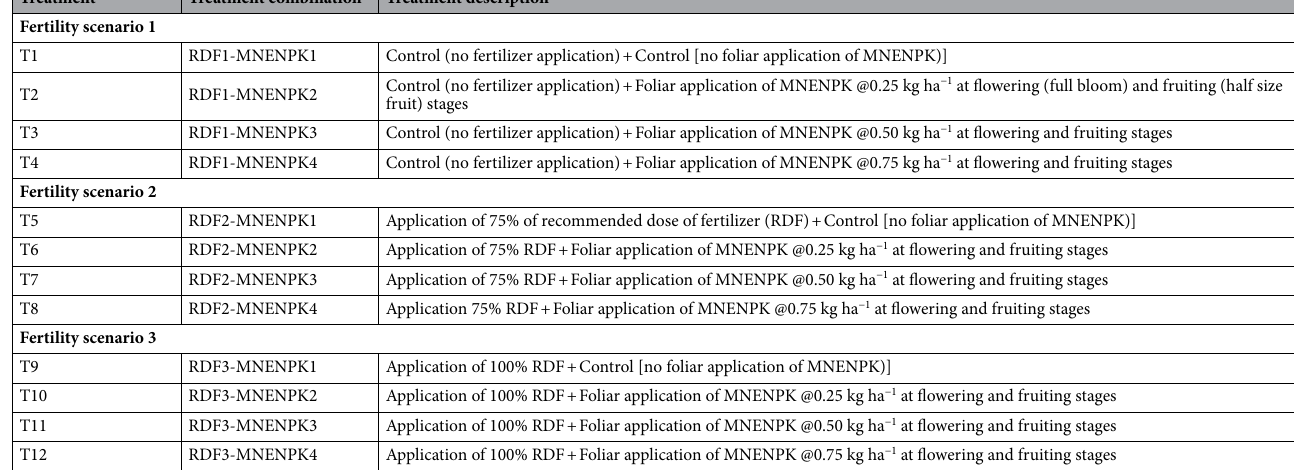
Table 5. Details of treatments applied to